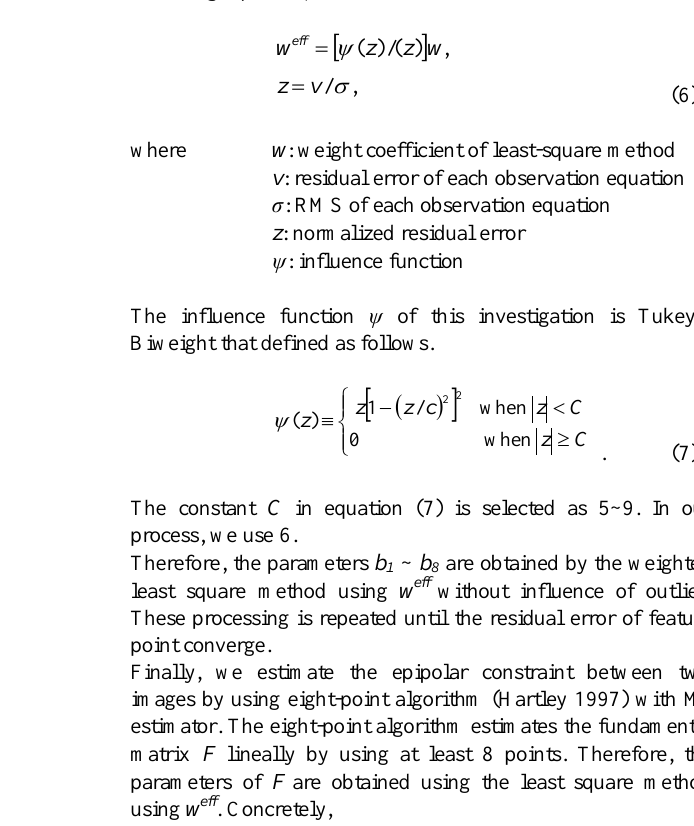
Figure 2. Processing Flow of Proposed Feature Point